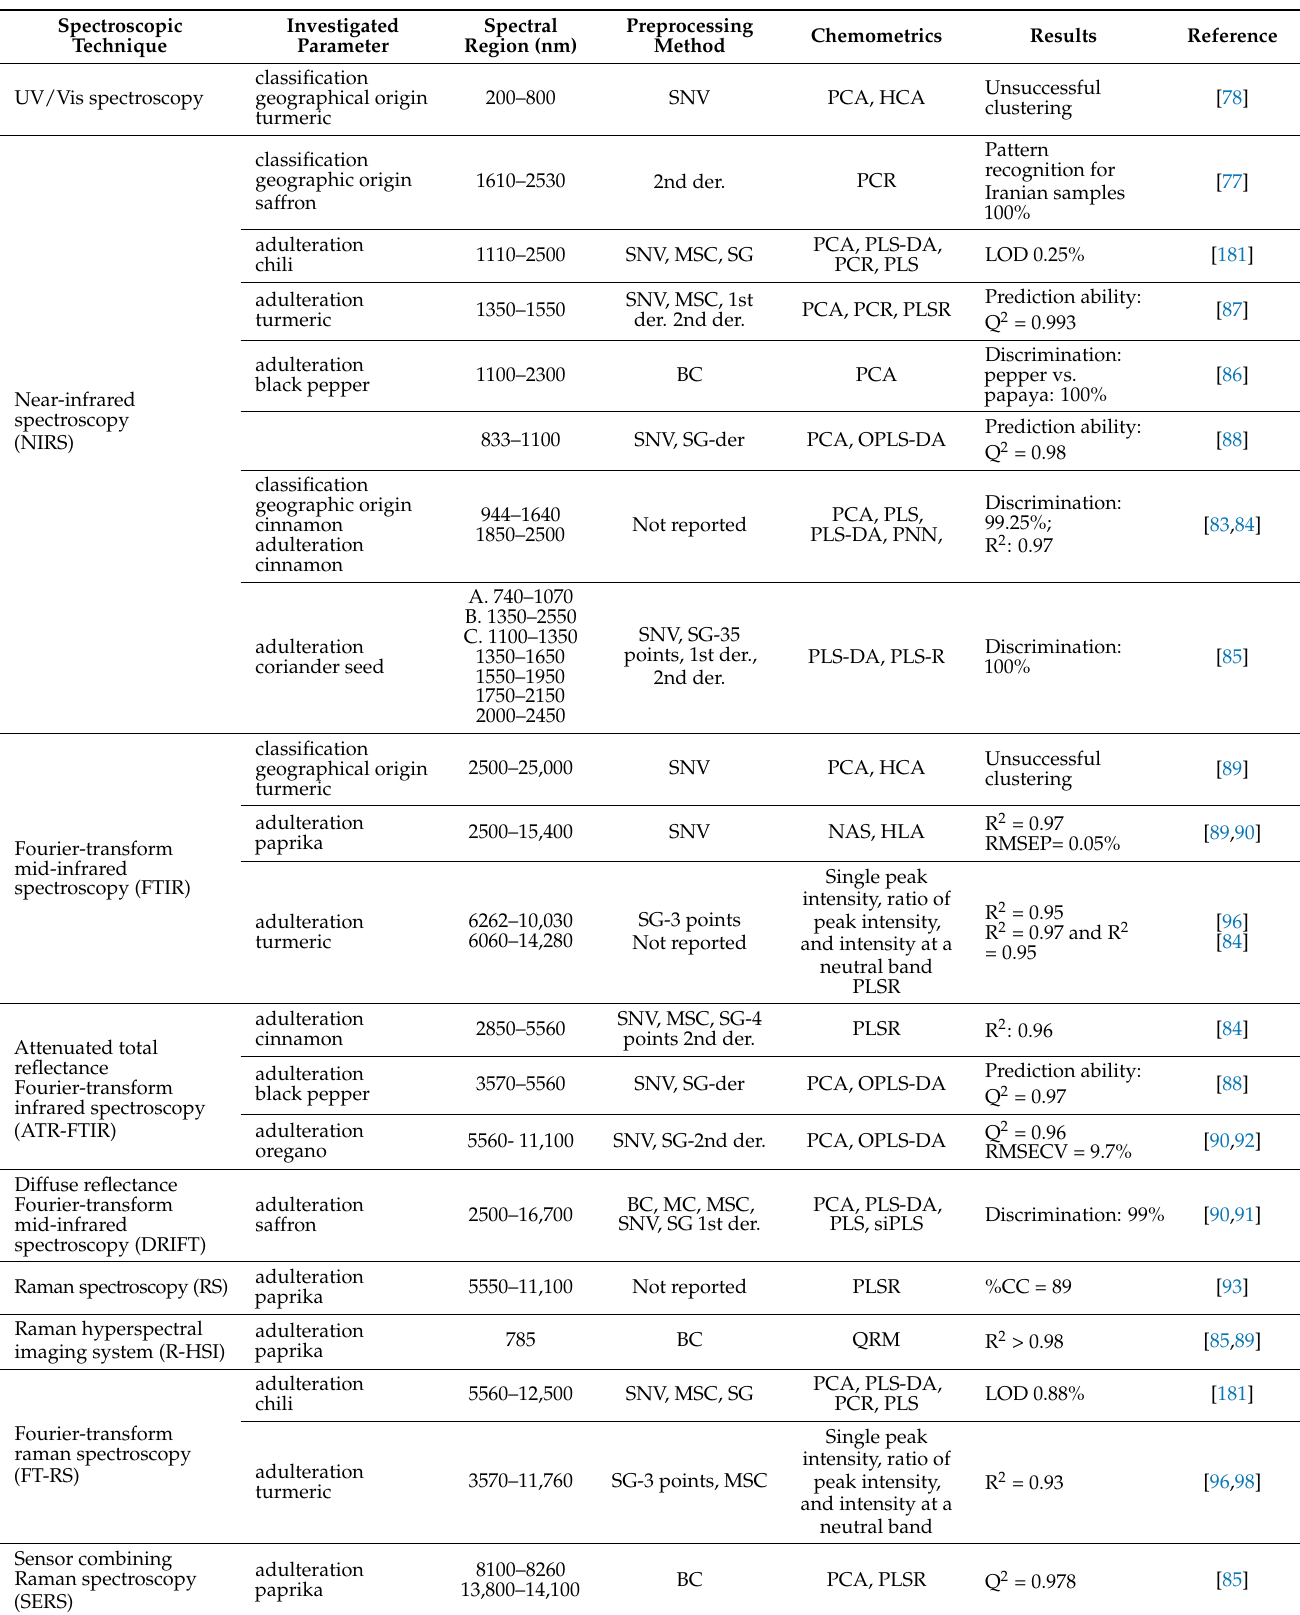
Table 6. Overview of molecular spectroscopic techniques for authentication and adulteration deter- mination in